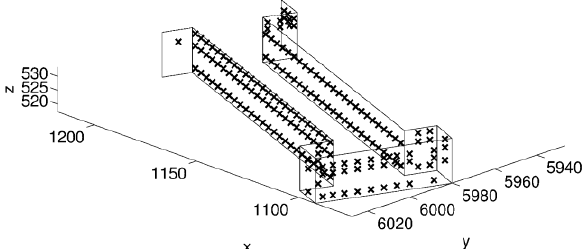
Figure 14. Ten façade planes of the Old Pinakothek, the black crosses represent the detected window positions Group a)